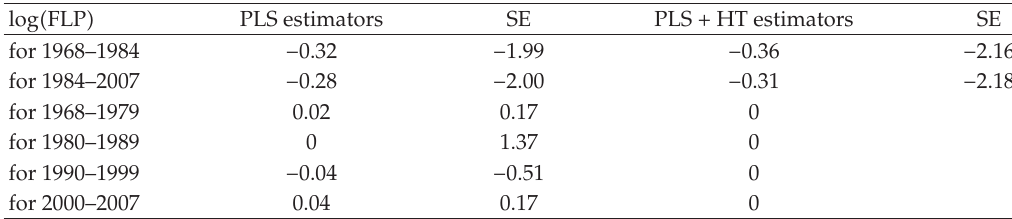
Figure 7: Plots of estimated curves, the solid line represents y ; the dotted lines are the estimated curves of y ; the dashed lines are the estimated curves of α . Table 11: Estimated coe ffi cients for Model